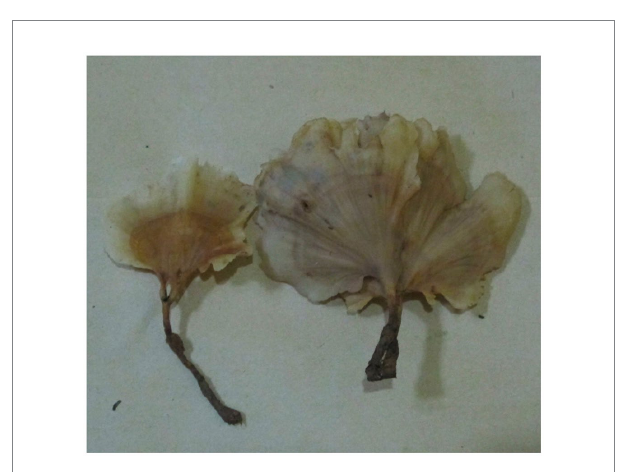
FIGURE 3 Basidiomata of Podoscypha petalodes subsp. cystidiata